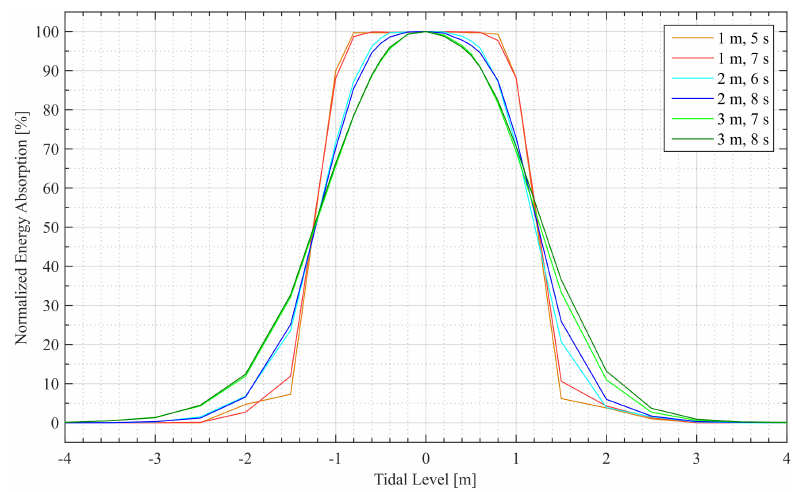
Figure 6. Energy absorption of the WEC in percentage for different tidal levels and different combinations of H s and T e . The normalization is carried out for each sea state with respect to the energy absorption at zero tidal